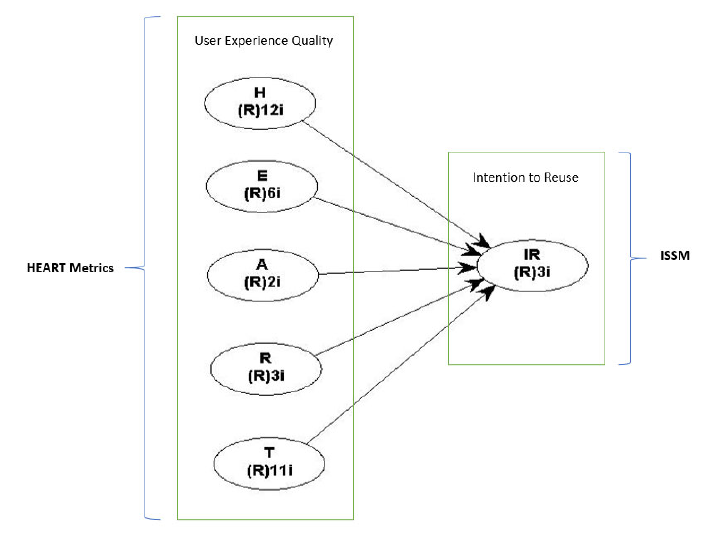
Fig. 1. Research Model Hypothesis